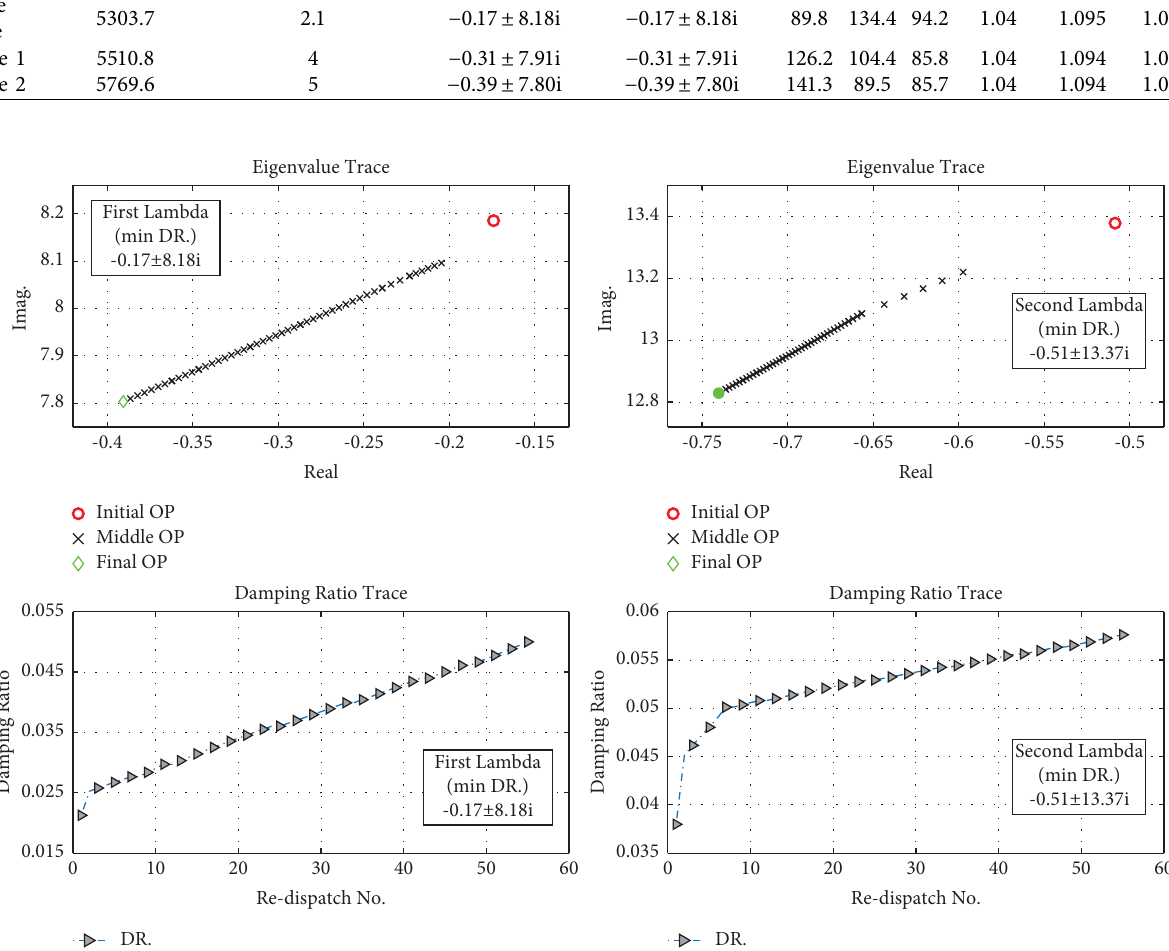
Figure 2: Te trace of two modes with the lowest damping ratio and their damping ratio. Table 2: Critical modes and their damping ratios under diferent operating points for IEEE 39-bus system. Mode